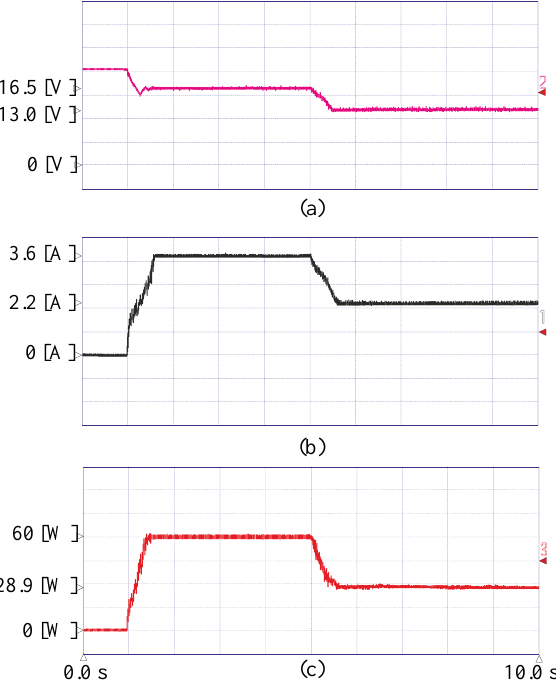
Figure 18. Experimental results of SA-P&O MPPT considering Case 2 ( a ) PV voltage, ( b ) PV current, and ( c ) PV